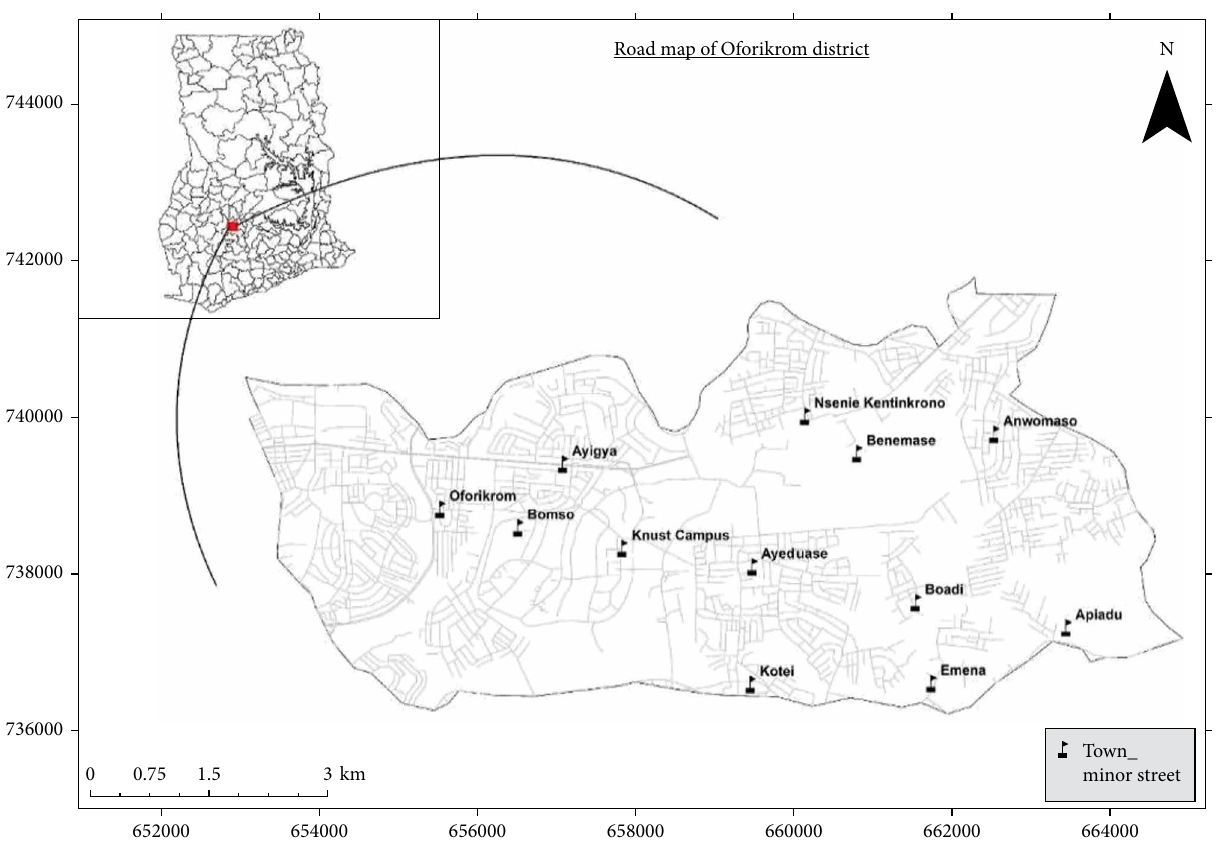
Figure 1: A map of Oforikrom